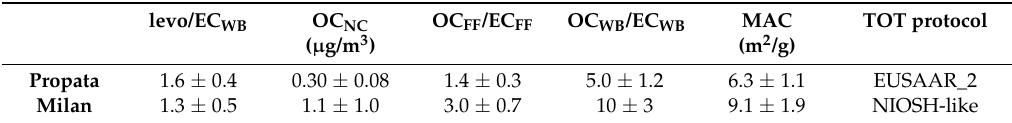
Table 2. Summary of values and variability for levoglucosan/EC WB ratio, OC NC , OC FF /EC FF , OC WB /EC WB , MAC (BC), and applied thermal protocol in Propata and Milan.